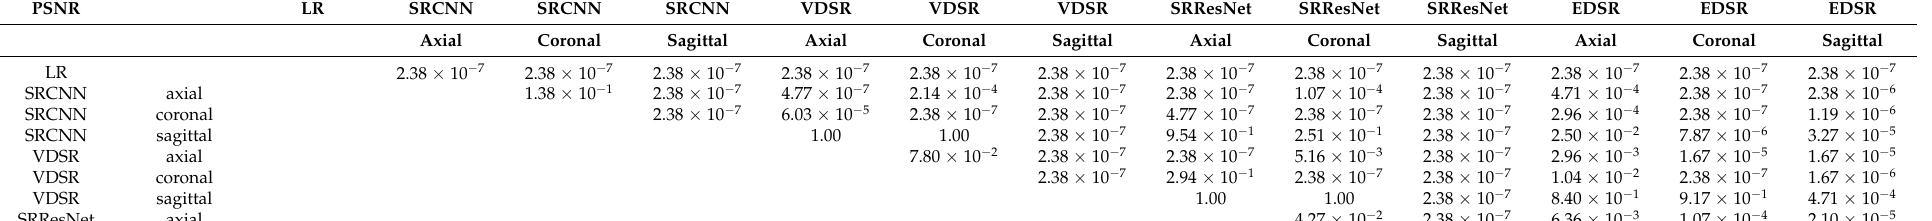
Table 6. p -values for comparing PSNR (upper table) and SSIM (lower table) values between different SR models applied to different planes. The SR methods in rows are better than those in columns when the corresponding p -values after Bonferroni correction are less than 6.41 × 10 − 4 in a one-sided Wilcoxon signed rank